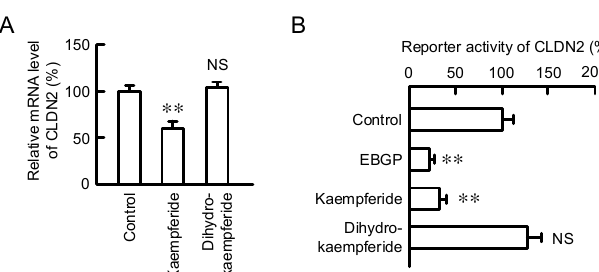
Figure 7. E ff ect of kaempferide on the transcriptional activity of CLDN2. ( A ) Cells were incubated with 10 µ M kaempferide or 10 µ M dihydrokaempferide for 6 h. The mRNA level of CLDN2 was examined by real-time PCR, and represented as a percentage relative to the control. ( B ) Cells were transfected with reporter vector of human CLDN2 and pRL-TK, an internal control. After treatment with 10 µ g / mL EBGP, 10 µ M kaempferide, or 10 µ M dihydrokaempferide for 6 h, the reporter activity was measured by the Dual-Luciferase Reporter Assay System and represented as a percentage relative to control. n = 4–5. ** p < 0.01 and NS p > 0.05 compared with control (One-way analysis). mRNA (F 4,9 = 18.16, p = 0.00069) and reporter activity (F 4,15 = 24.45, p < 0.0001).